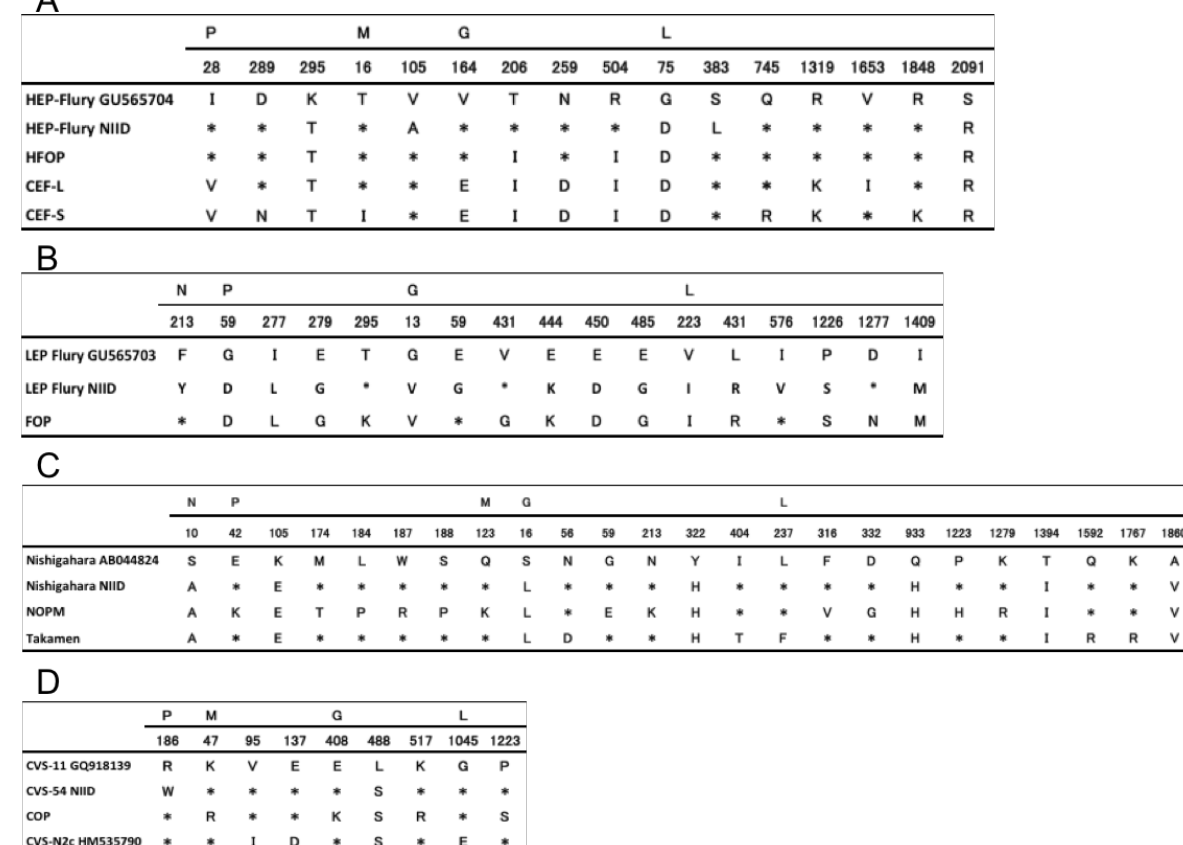
Figure 3. Comparison of the deduced amino acid sequence of rabies viruses. We compared the deduced amino acid sequences of ( A ) HEP-Flury-related strain, ( B ) LEP-Flury-related strain, ( C ), Nishigahara-related strain and Takemen strain, and ( D ) CVS-related strain. The first row shows the sequences of the HEP-Flury strain (GU565704), LEP-Flury (GU565703), Nishigahara (AB044824), and CVS-11 (GQ918139) strains with a one-letter symbol. For the other strains, only nonidentical amino acids are depicted at each corresponding position of the first-row strain, and identity is depicted as *.